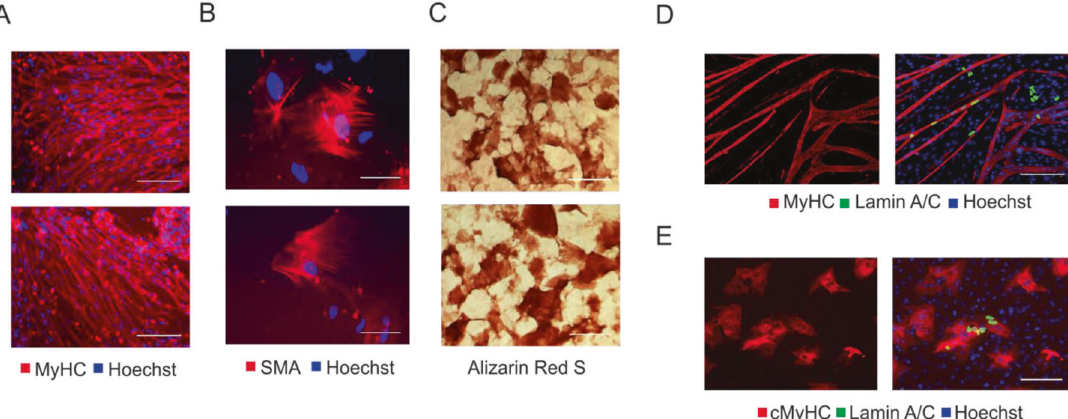
Fig. 2 Mesodermal progenitors have the potential to differentiate towards multiple mesodermal lineages and contribute to in vitro cardiac and skeletal muscle formation. A Immuno fl uorescence of MyHC (red) after myogenic differentiation. B Immuno fl uorescence after smooth muscle differentiation (SMA). C Alizarin red S staining after osteogenic differentiation of the mesodermal progenitors. D – E Immuno fl uorescence analysis of lamin A/C-positive mesodermal progenitors (green) in co-culture with either C2C12 myoblasts (D) or rat cardiomyocytes (E ). Scale bars: 100